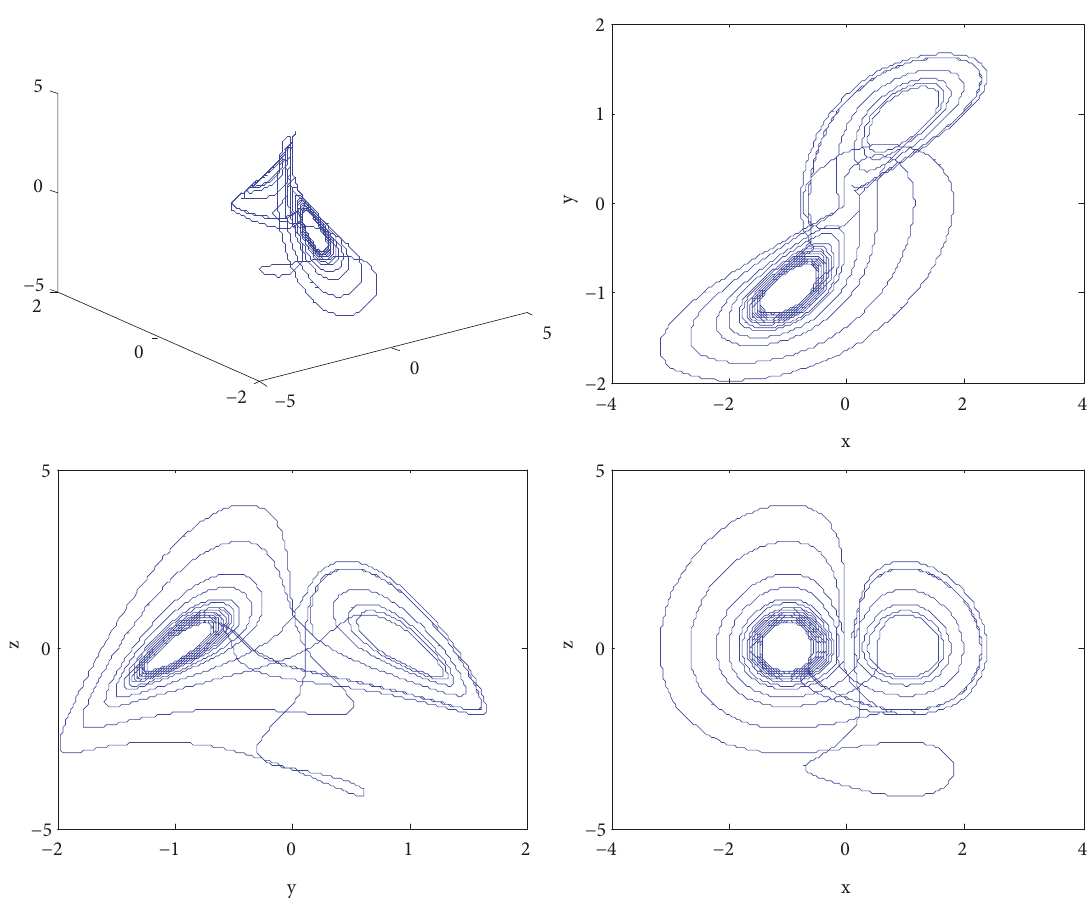
Figure 2: Phase diagram of system